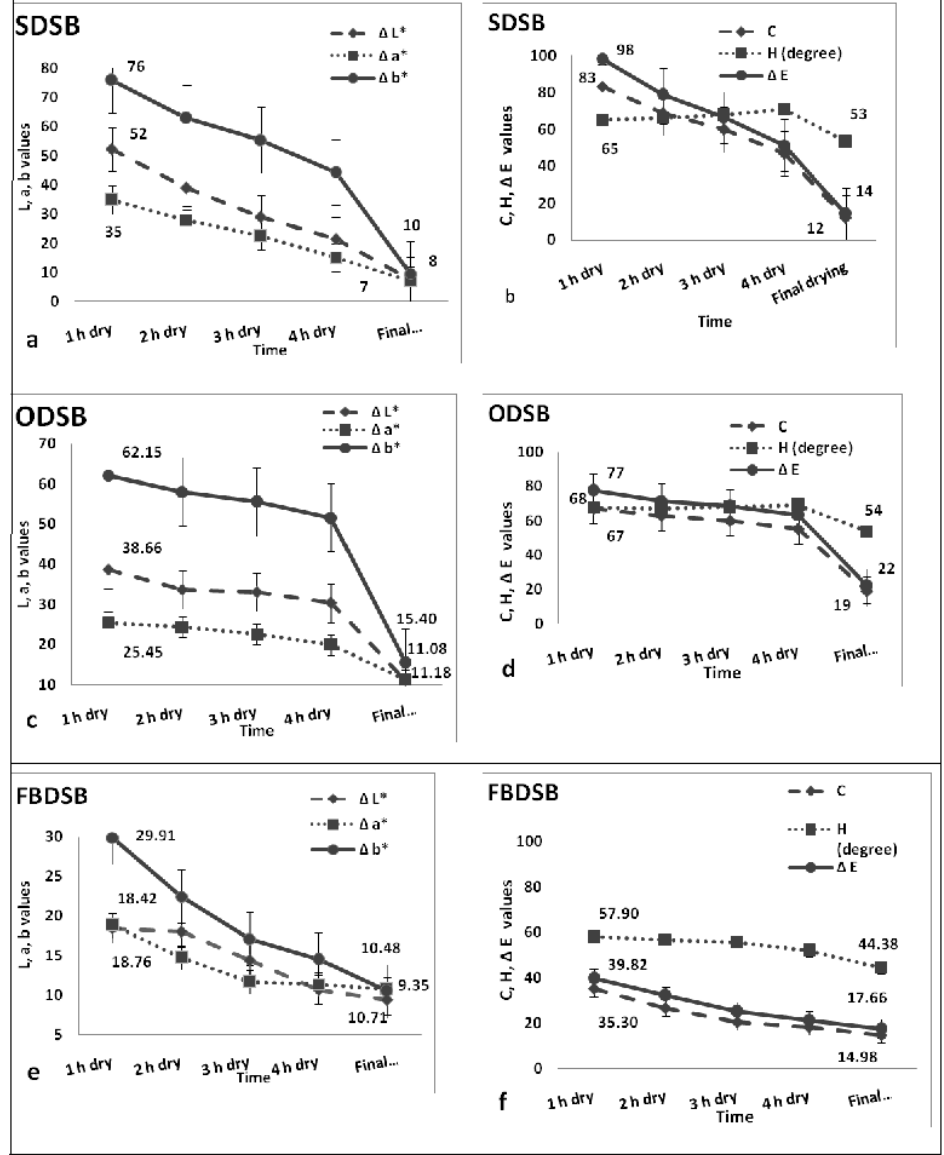
Figure 2. ( a – f ): Change in color values of Turmeric with drying time ( a ): L*, a*, b* values of sun dry sliced boiled; ( b ): C, H, ∆ E values of sun dry sliced boiled. ( c ): L*, a*, b*values of oven dry sliced boiled; ( d ): C, H, ∆ E values of oven dry sliced boiled. ( e ): L*, a*, b* values of fluidized bed dry sliced boiled; ( f ): C, H, ∆ E values of fluidized bed dry sliced